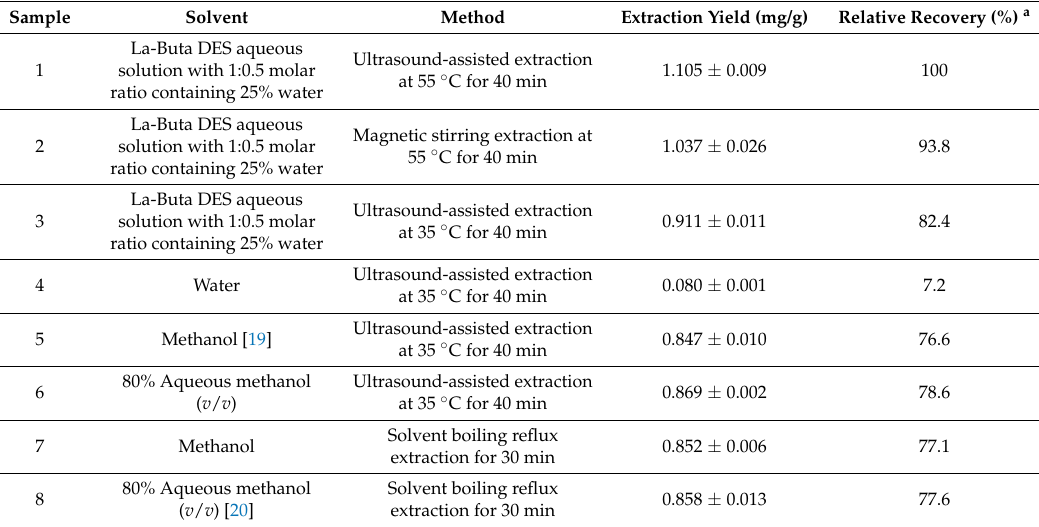
Table 5. Comparison of the method developed in this work with other extraction procedures for extraction of rutaecarpine in the unripe fruits of T . ruticarpum